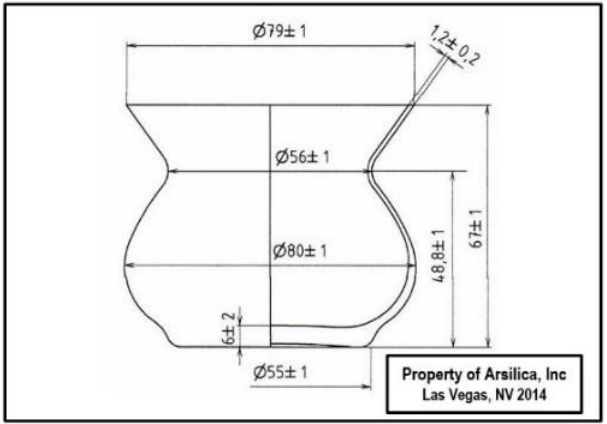
Figure 8. Spirits nosing and tasting vessel engineered by physical science. Note the advantages of the design for each specific area of the final shape (Additional description at Supplementary Video S2).